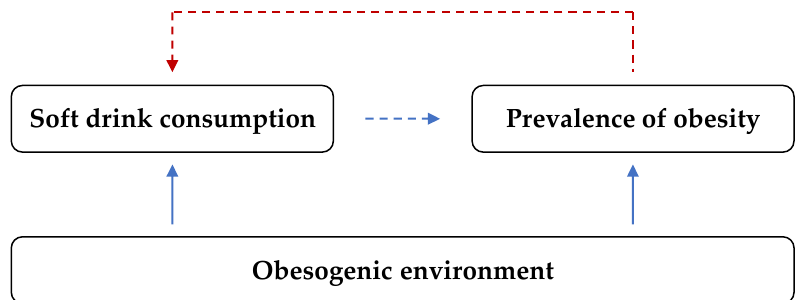
Figure 1. Interplay between soft drinks and obesity.